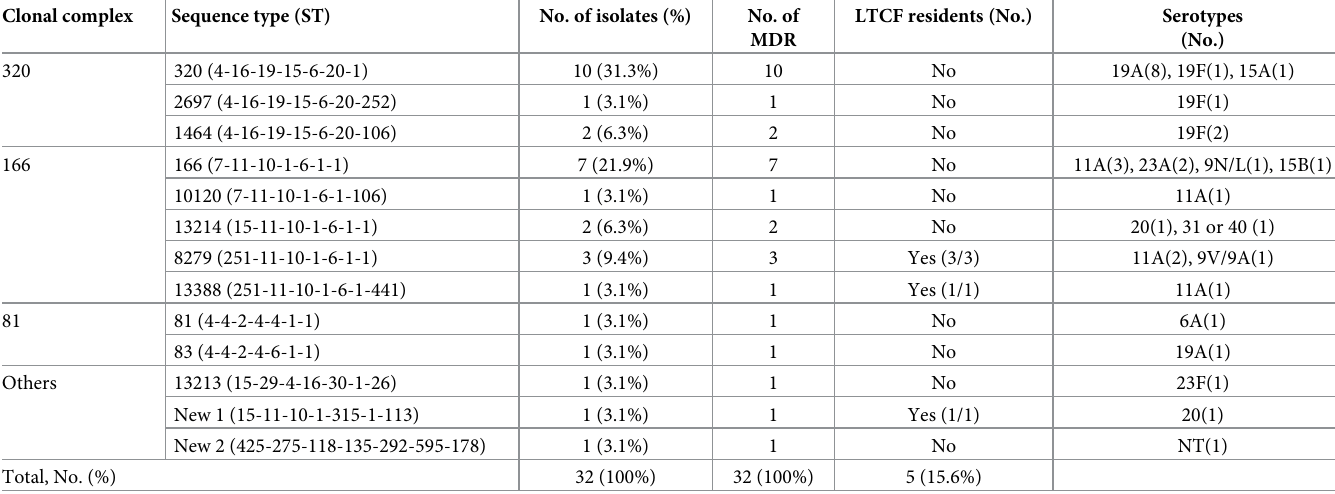
Table 5. Distribution of sequence types and serotypes among 32 ceftriaxone non-susceptible S . pneumoniae isolates. Clonal complex Sequence type (ST)